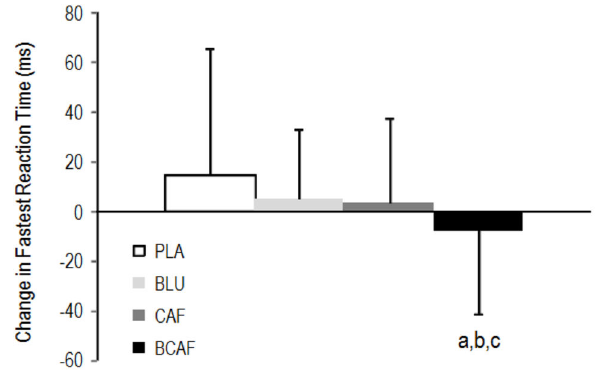
Figure 3. Change in the accuracy in incongruent presentations in the Eriksen flanker psychomotor task. a: large difference from CAF, b: large difference from BCAF, c: moderate difference from CAF, d: moderate difference from BCAF. PLA: white light/placebo; CAF: white light/240 mg caffeine; BLU: blue light/placebo; BCAF: blue light/240 mg caffeine. doi: